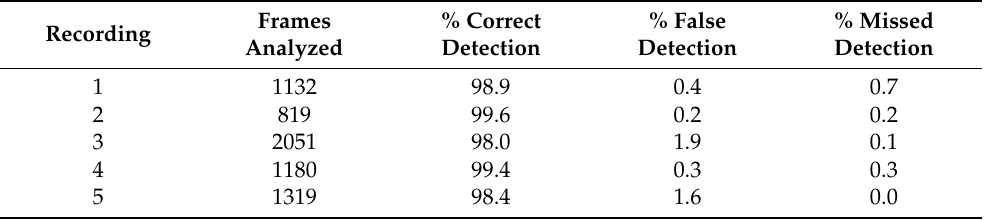
Table 2. Marker detection rates for recording sessions with device worn by clinician, simulating real-world usage of